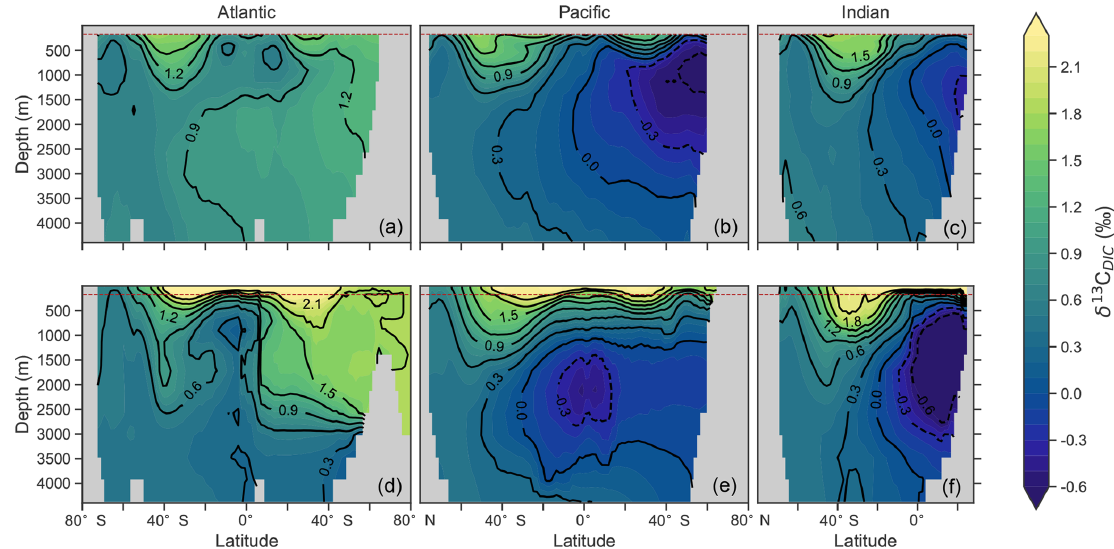
Figure 3. Zonal mean observed (a, b, c) and modelled (d, e, f) δ 13 C of DIC produced by CSIRO Mk3L-COAL for each major basin. The red dashed line marks the upper 175m and is used for comparison between observed and modelled distributions. Replicate figures for the other models are available in the Supplement.